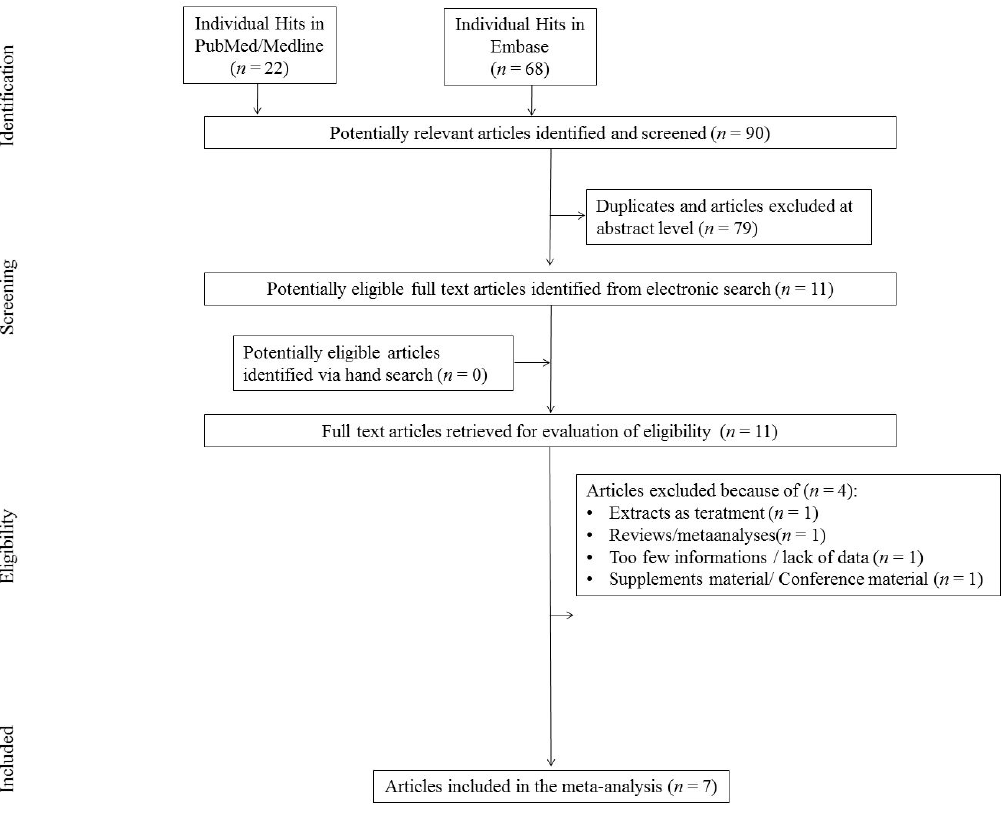
Figure 1. Figure 1. Flowchart.